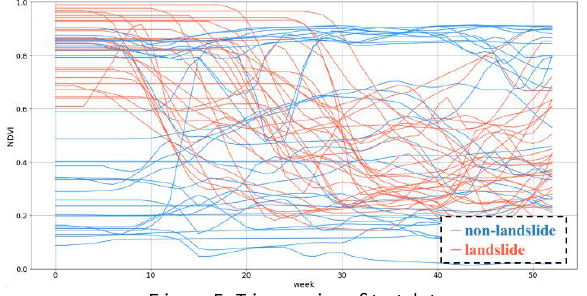
Figure 5. Time series of test data